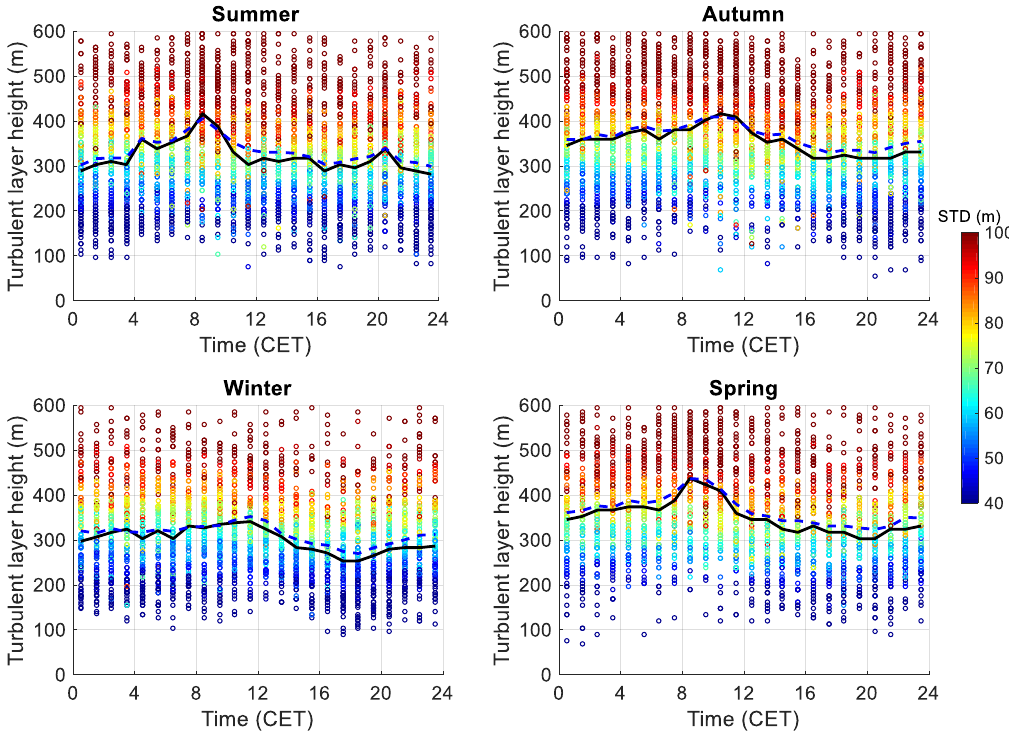
Figure 21. Summarised diurnal behaviour of the turbulent layer depth for different seasons in 2015–2017. Colours of circles indicate the standard deviation of H TL (in m) estimated over 1 h. Solid black lines depict median values and dashed blue lines indicate the arithmetic mean values.